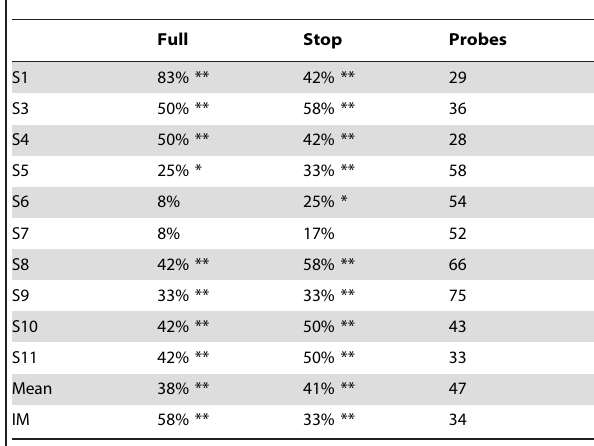
First two columns indicate proportion correct, last column indicates the number of probes used to obtain the accuracy for the stop condition, for the full condition this is always 100. Asterisks indicate whether the proportion correct differs significantly from chance level (1/150, 0.00667). * indicates .001 , p , .05, ** indicates p , .001.